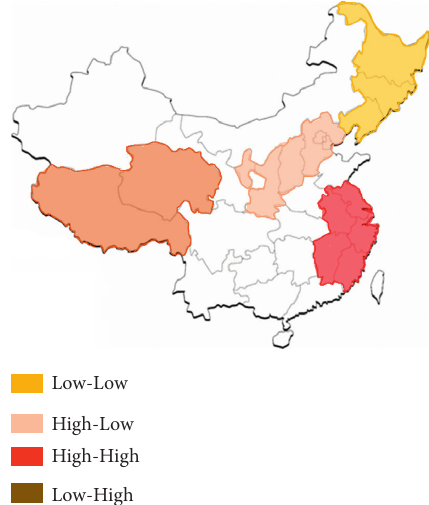
Figure 10: Influence diagram of significant coefficient of regional economic